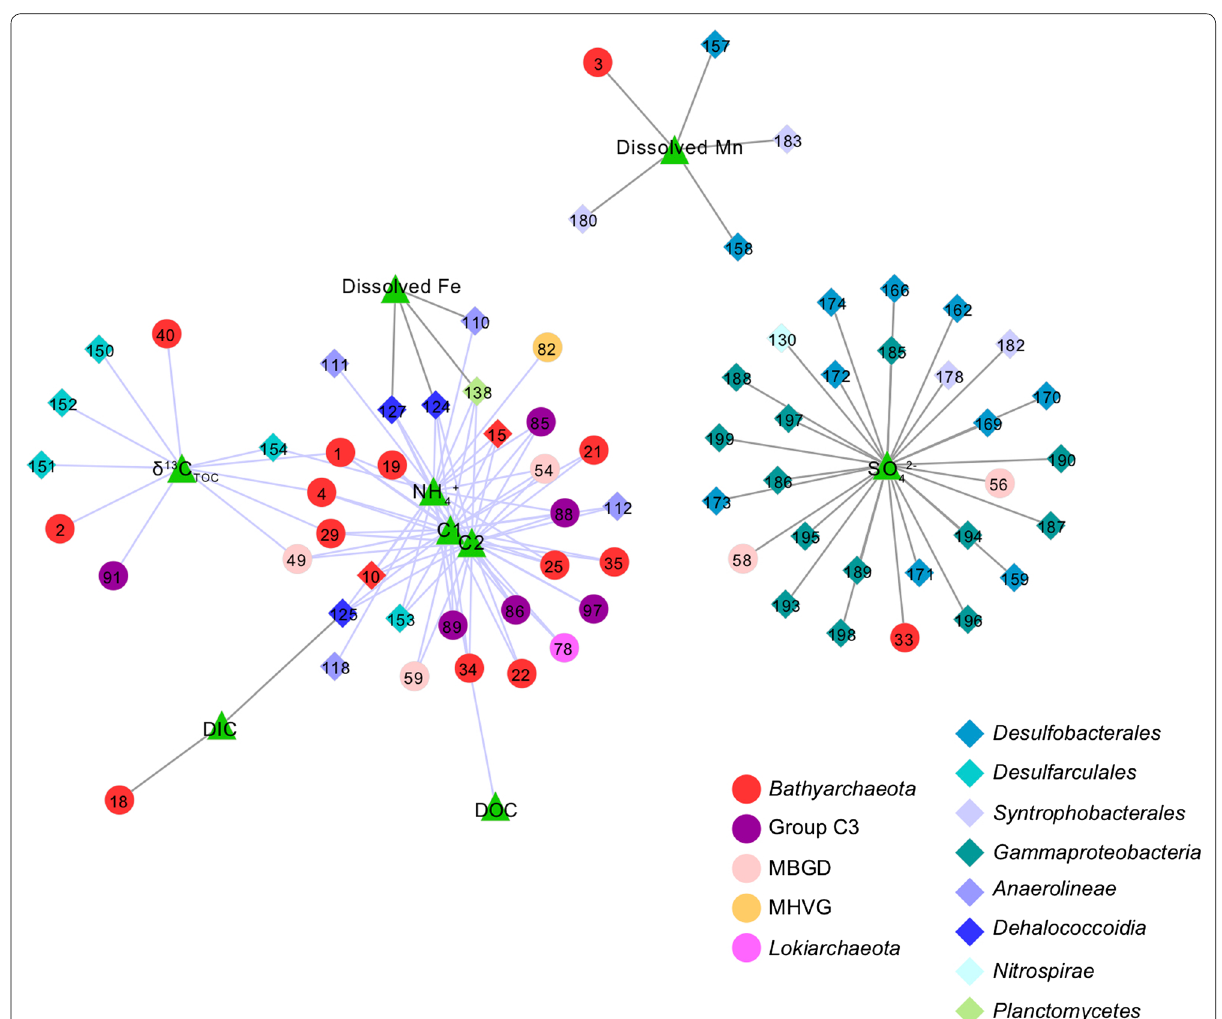
Fig. 5 Network interactions revealed relationships between microbial and geochemical factors with a threshold of 0.65 for spearman’s coefficient and 0.0001 for P-value. Purple lines indicated positive correlations with electron donors. Gray lines indicated positive correlations with electron acceptors. Circles: Archaeal OTUs; Diamonds: Bacterial OTUs; Triangles: Geochemical factors. The numbers representing generated OTU IDs were shown in Additional file 4: Table